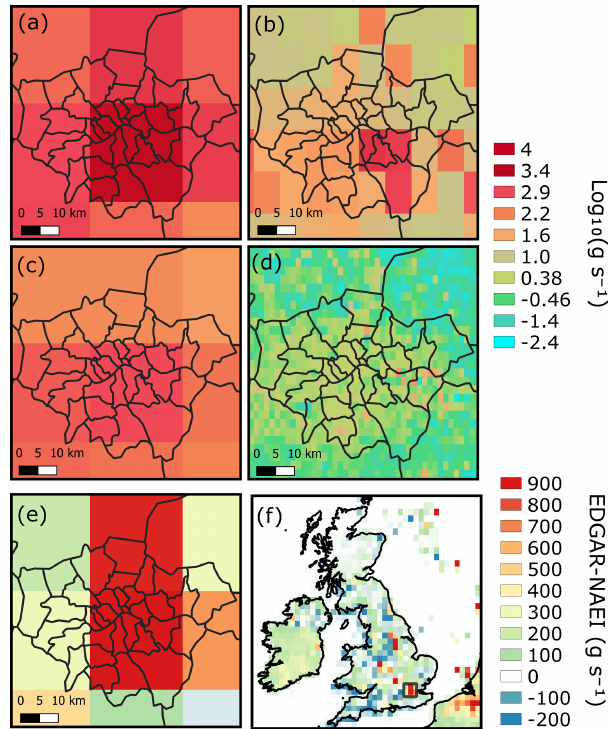
Figure 3. London CH 4 emissions from (a) EDGAR v4.3.2 (2012) scaled at 0.352 ◦ × 0.234 ◦ , (b) EDGAR scaled at 0.10 ◦ × 0.10 ◦ , (c) UK NAEI (2017) scaled at 0.352 ◦ × 0.234 ◦ , and (d) UK NAEI scaled at 0.02 ◦ × 0.02 ◦ . The NAEI scaled at 0.352 ◦ × 0.234 ◦ sub- tracted from the EDGAR emissions (in gs − 1 ) for London is shown in (e) and for the UK in (f) . The London region in relation to the UK is shown by the black box in (f)